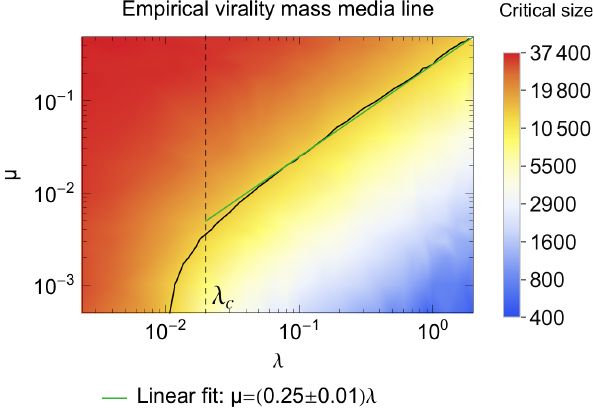
FIG. 3. The color density plot represents the network size at the critical point for the respective parameters λ and μ . For constant λ , an increase of μ leads to a later transition (red area), whereas for constant μ , one observes an earlier transition (blue area) for higher values of λ . The solid black line indicates the virality mass media line corresponding to the critical size of Pokec ( N P c ¼ 10600 ). The green line shows a linear fit in the region above the sustained activity threshold λ c ¼ 0 . 02 (see Supple- mental Material